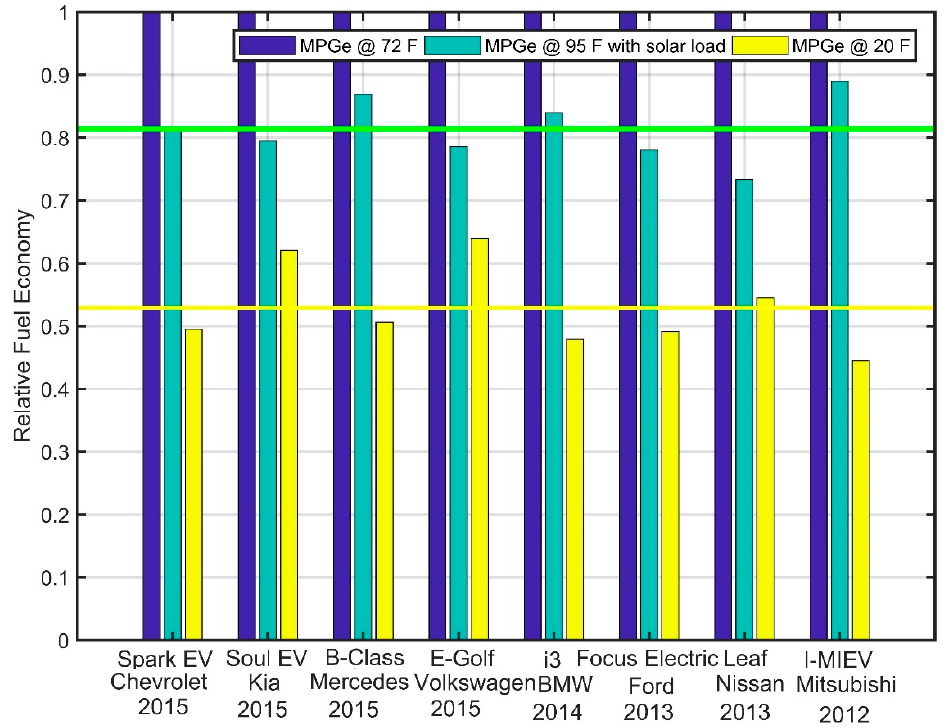
Figure 8. Effect of ambient conditions on BEV fuel economy. Yellow and green lines represent average values for MPGe at 95 F with solar load and 20 F respectively. The fuel economy was over the UDDS cycle.